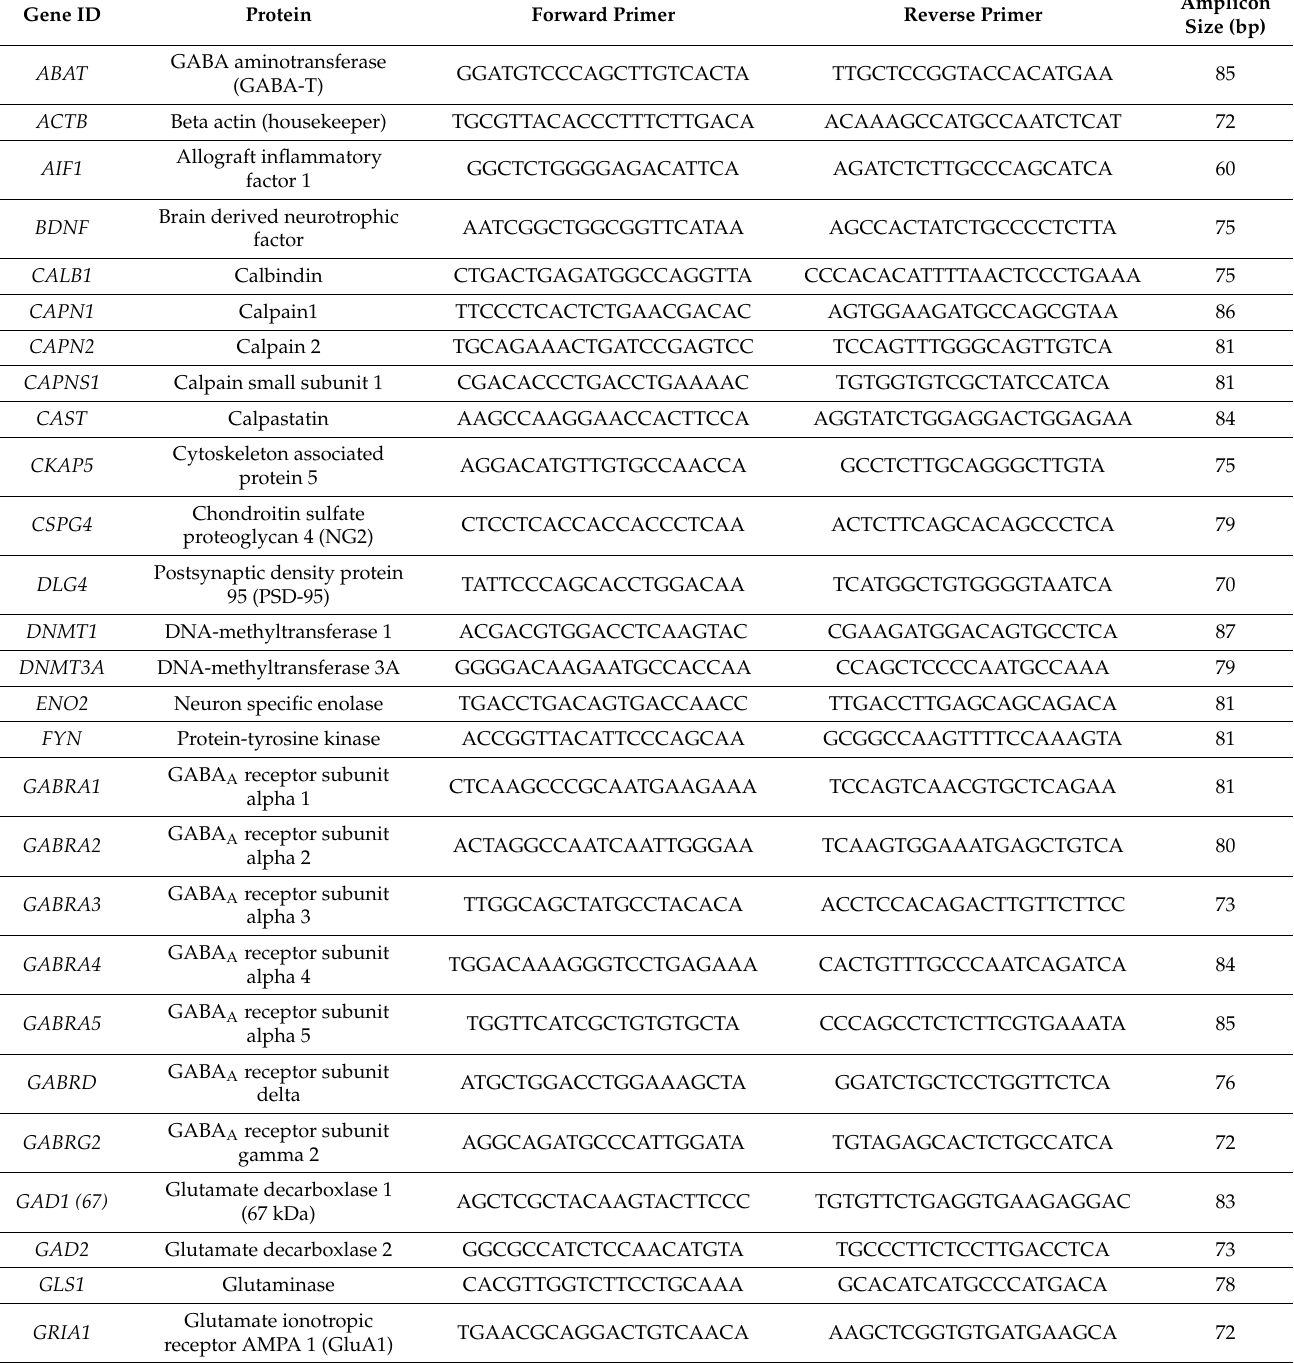
Table 1. Guinea pig specific primers for high throughput Fluidigm mRNA